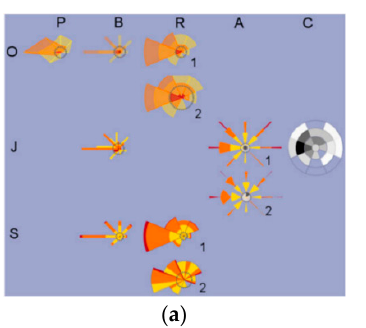
Figure 50. Flow-selection visualization for the United States migration [131], showing: ( a ) overall net migration flows; ( b ) zoomed-in flow map; ( c ) flow map for senior migrants; and ( d ) flow map for young migrants.